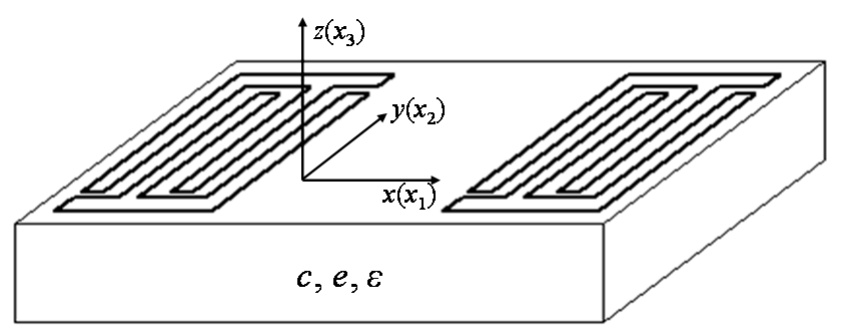
Figure 2. The coordinate system used in this study.